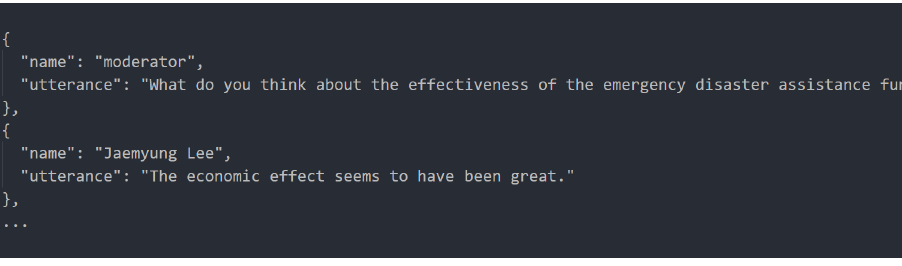
Figure 3. Data structure organized by each speaker’s utterance